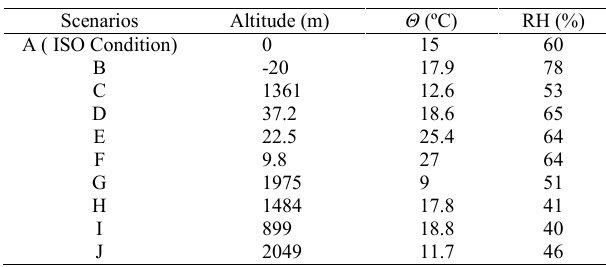
Table 3: Site condition scenarios description